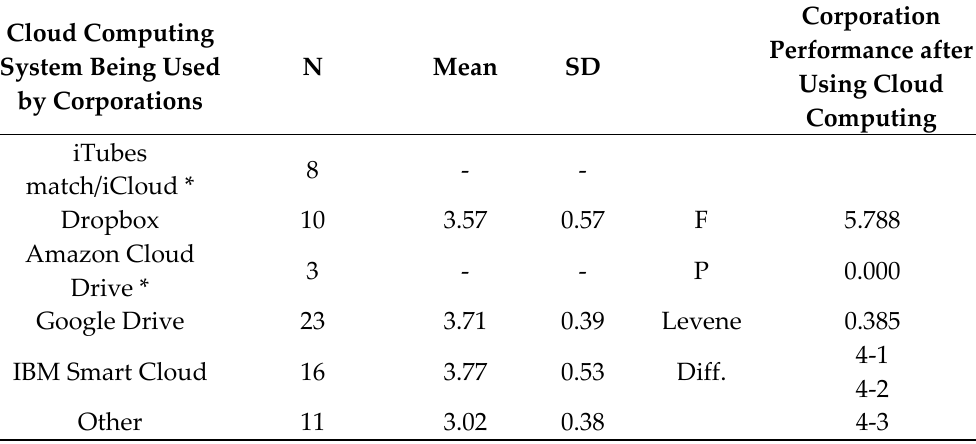
Table 2. Diversification situations of participants’ points gained from corporation performance scale after cloud computing system usage with respect to cloud computing service application being used by the corporation.